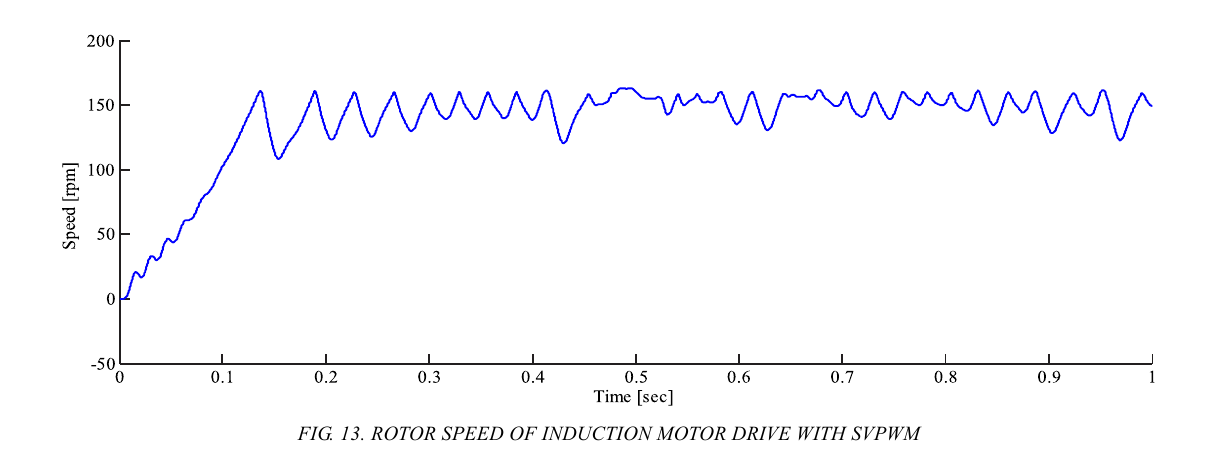
FIG. 13. ROTOR SPEED OF INDUCTION MOTOR DRIVE WITH